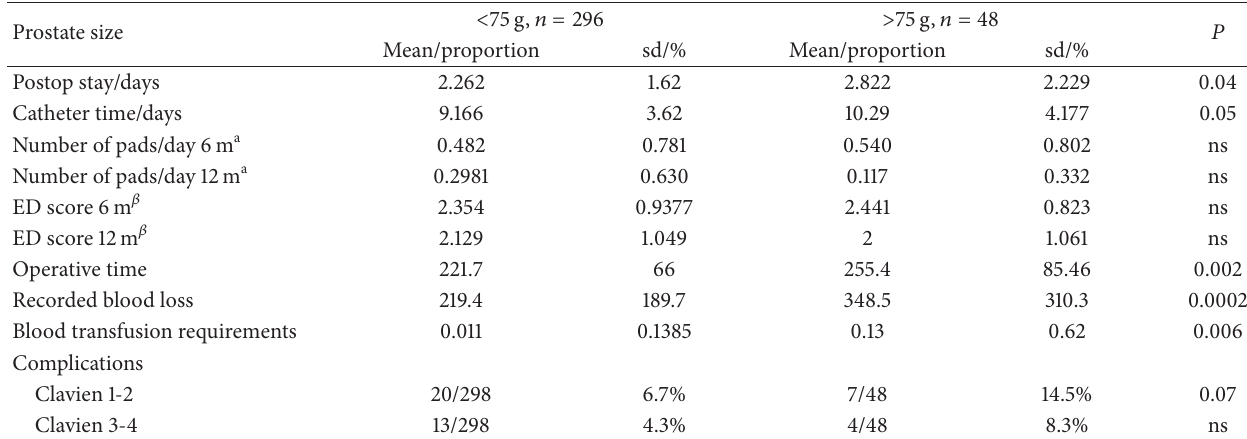
Table 3: Postoperative outcomes and complications of